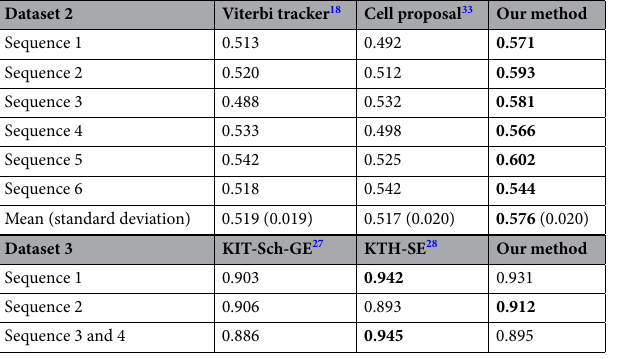
Table 9. Cell tracking performance on dataset 2 and dataset 3 using TRA. The bold values represent the best performing method for each of the